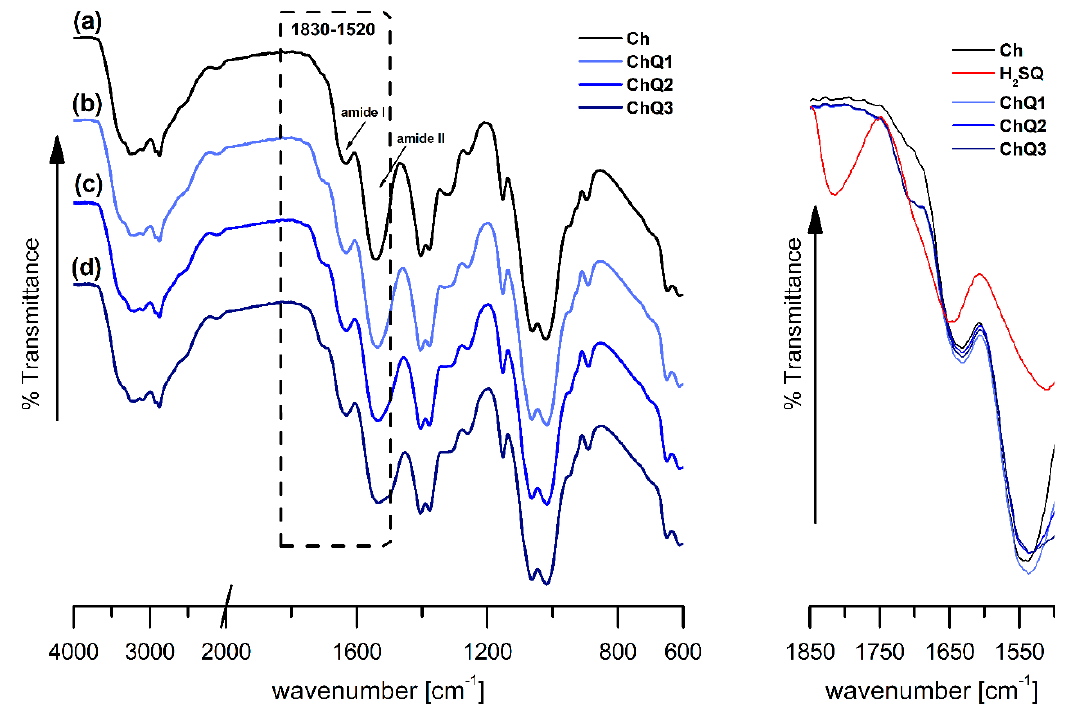
Figure 3. FTIR-ATR spectra of ( a ) chitosan (Ch) and squaric acid-crosslinked chitosan, ( b ) ChQ1, ( c ) ChQ2, and ( d ) ChQ3 (left: stacked spectra, right: overlapped spectra).